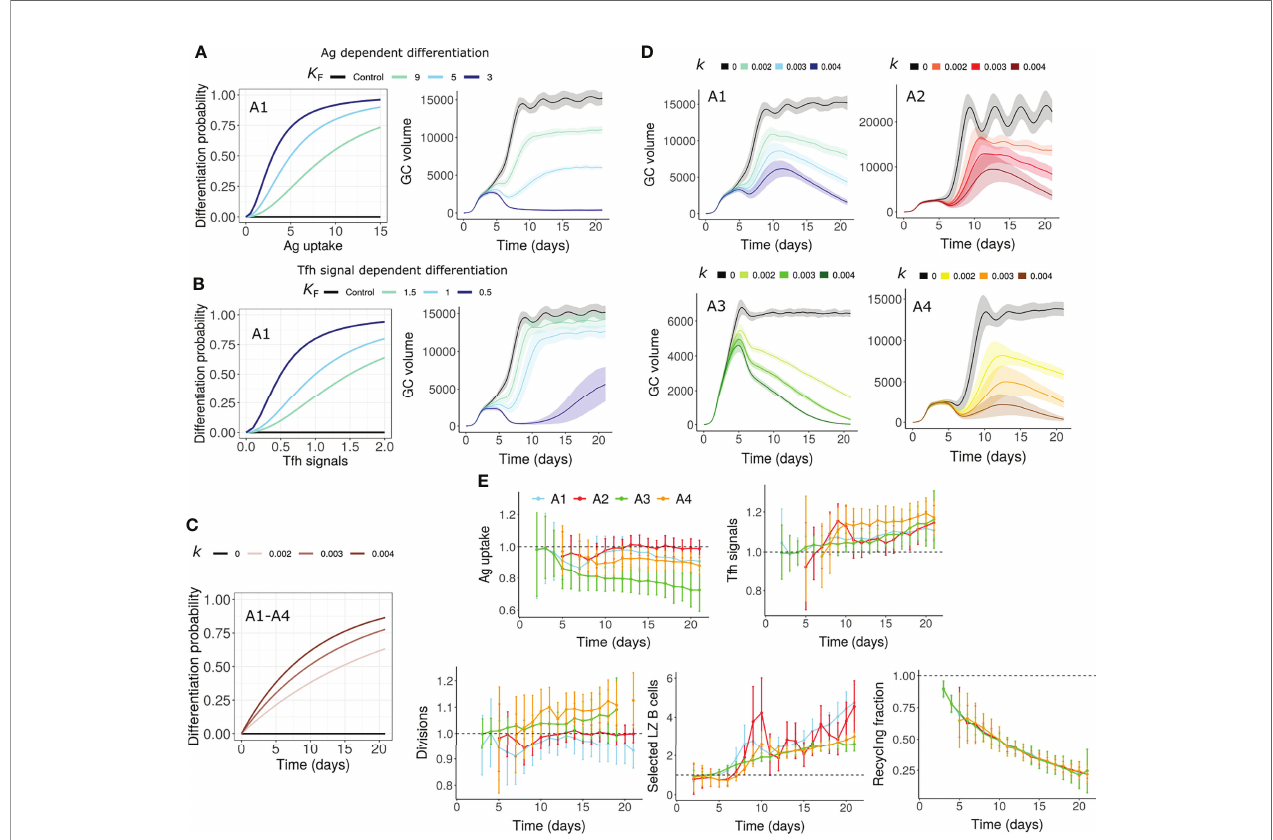
FIGURE 4 | GC shutdown due to terminal differentiation of B cells (Mechanism 6). (A, B) Differentiation probability in antigen dependent (A) and Tfh signal dependent (B) terminal differentiation and corresponding GC volume dynamics. Colors represent different values of K F in Equation 9. K F is the amount of Ag captured (in antigen dependent terminal differentiation) or Tfh signals received (in Tfh signal dependent terminal differentiation) for half-maximal differentiation probability (see Methods). Assumption A1 was considered in these simulations. (C, D) Terminal differentiation probability vs time according to Equation 10 in assumptions A1-A4 for time dependent terminal differentiation (C) . Colors represent different values of k and corresponding GC dynamics (D) . Black curves represent control simulations. Different colors represent value of k in Equation 10 and are shown in labels above (C, D) Value of k controls the increase in differentiation probability. Solid lines and shaded regions in panels A, B and D represent mean and standard deviation of 50 simulations, respectively. (E) Average antigen uptake per B cell, Tfh signals acquired per B cell, average number of divisions per recycling GC B cell and fraction of Tfh selected LZ B cells for time dependent terminal differentiation ( k = 0.003). Readouts were normalized with that of the control simulation. Colors represent the assumptions A1-A4. Error bars represent standard deviation of 50 simulations. GC, Germinal center; Tfh, T follicular helper cell; Ag, Antigen; LZ, Light